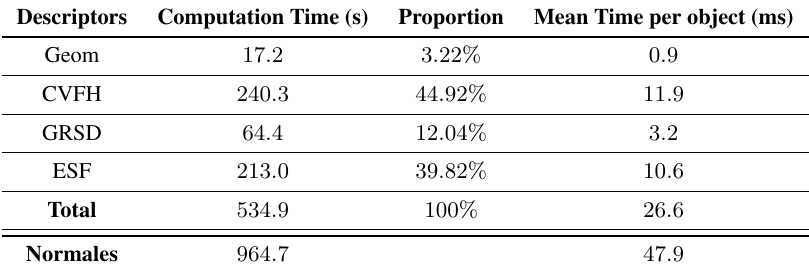
Table 5: Mean Computational Time of descriptors on 20121 segmented objects of 7 passes in Lille and Paris